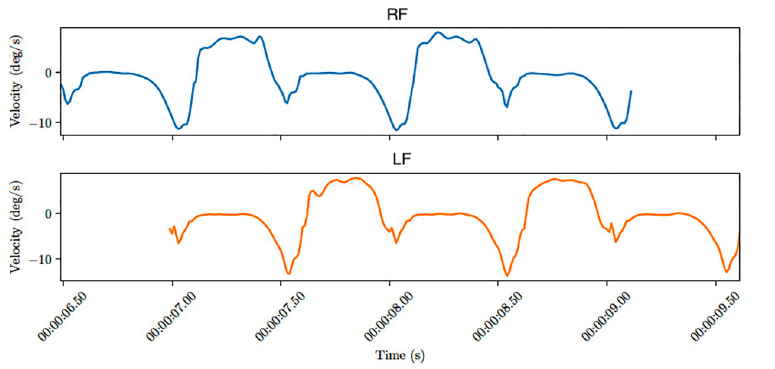
Fig 2. Two gait signals from a healthy subject. Top: right foot. Bottom: left foot.